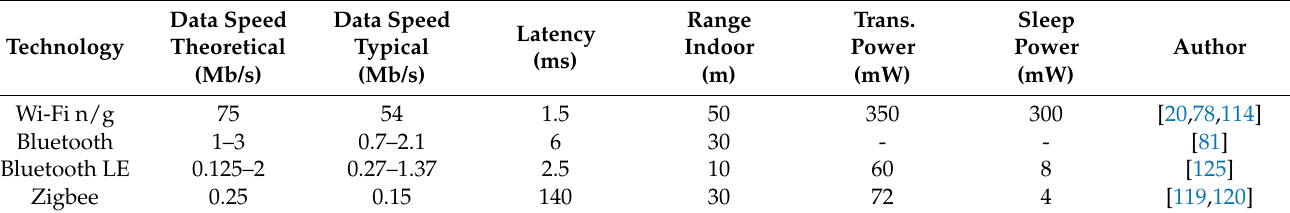
Table 2. Specifications of wireless communication protocols for TCM sensor